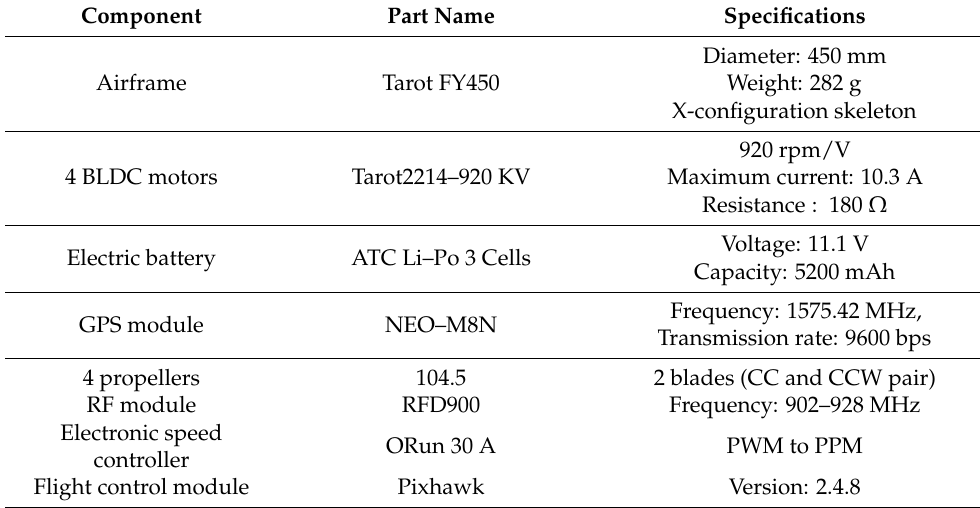
Table 3. Hardware components quadrotor model parameters.